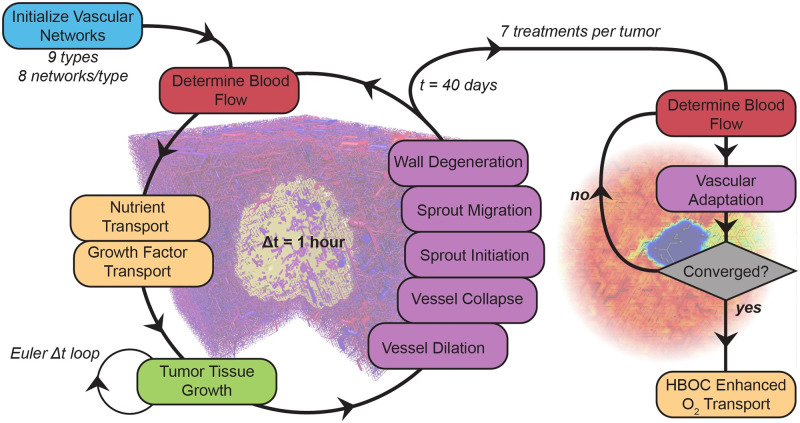
Model flow diagram.At each time step, blood flow, distribution of nutrients/growth factors and vascular remodeling are computed. The tissue phase remodels at shorter time steps within the main loop. The resulting artificial tumors are transferred to the infusion model. Hemodilution and the HBOC enhanced viscosity modulates flow and vascular adaptation until the microvascular system is stable. After this, HBOC enhanced oxygenation is modeled.